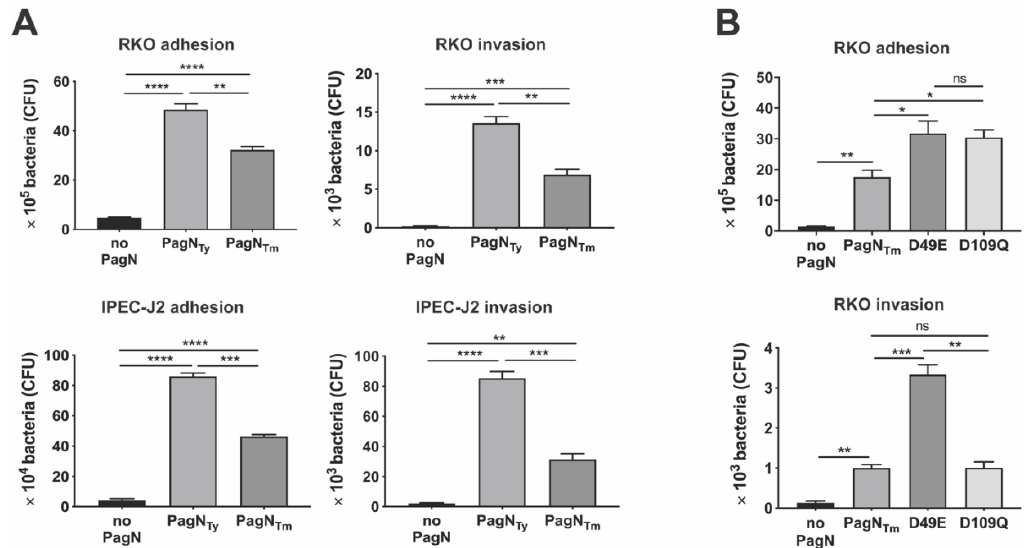
Figure 3. Binding and uptake of E. coli AAEC189 to intestinal epithelial cells mediated by PagN expression. ( A ) Adherence and invasion of E. coli AAEC189 with empty vector pRS1 (no pagN), pDMS1973 or pDMS1974 to express PagN Ty or PagN Tm respectively, to human (RKO) and porcine (IPEC-J2) was analyzed by incubating 3 × 10 7 CFU/mL bacteria at a MOI of 100 for 60 min for adherence and another 90 min for invasion assays. Bacteria expressing PagN Ty bound and invaded significantly better than the bacteria expressing PagN Tm ( p < 0.01–0.001). ( B ) Adherence of E. coli AAEC189 expressing PagN Tm to RKO cells was significantly enhanced ( p < 0.05) when PagN Tm was mutated from aspartate to glutamate (at site 49, D49E) with pDMS2081 or to glutamine (at site 109, D109Q) with pDMS2082, whereas invasion of epithelial cells was affected only by the D49E substitution ( p < 0.001), but not by the D109Q substitution. Data represent one of three separate and reproducible experiments each with triplicate data expressed as mean ± SEM (ns is for not significant, * p < 0.05, ** p < 0.01, *** p < 0.001 and **** p < 0.0001).